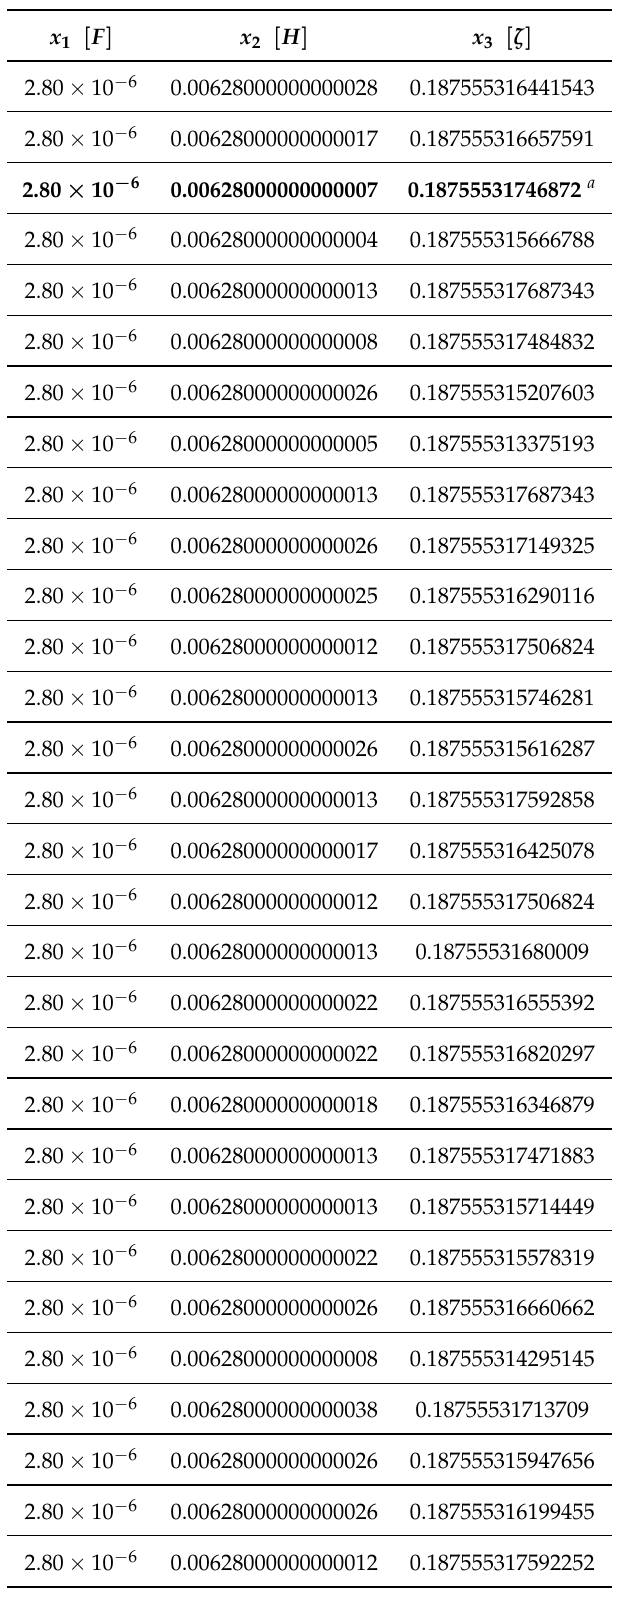
Table 1. Best individuals obtained for the input filter